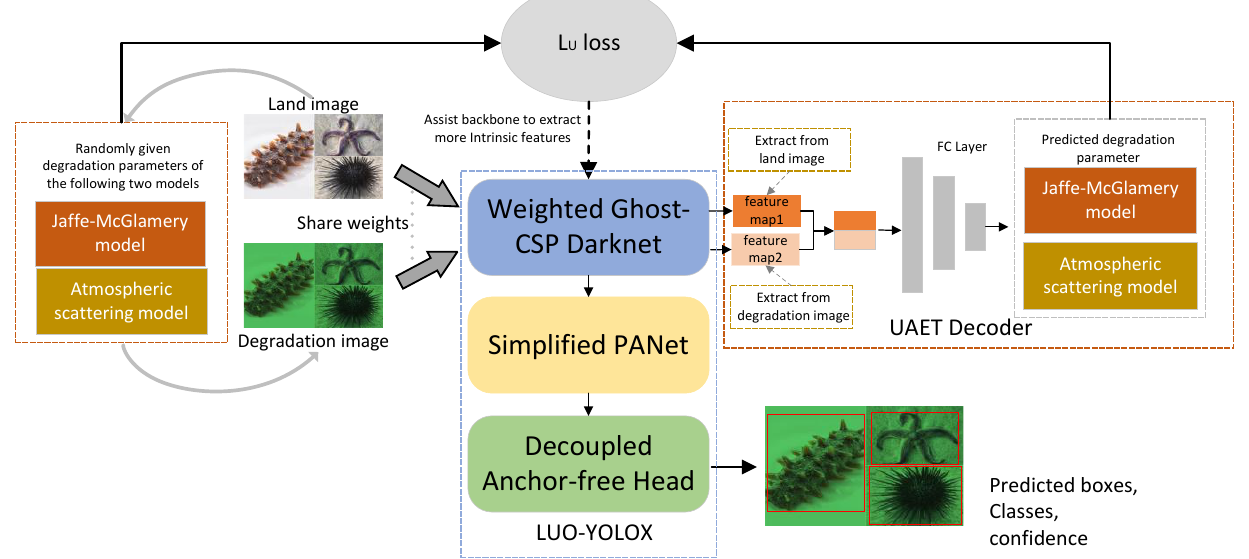
Figure 1. The overall architecture of the proposed self-supervised pre-training joint framework; L U loss is the loss of the UAET